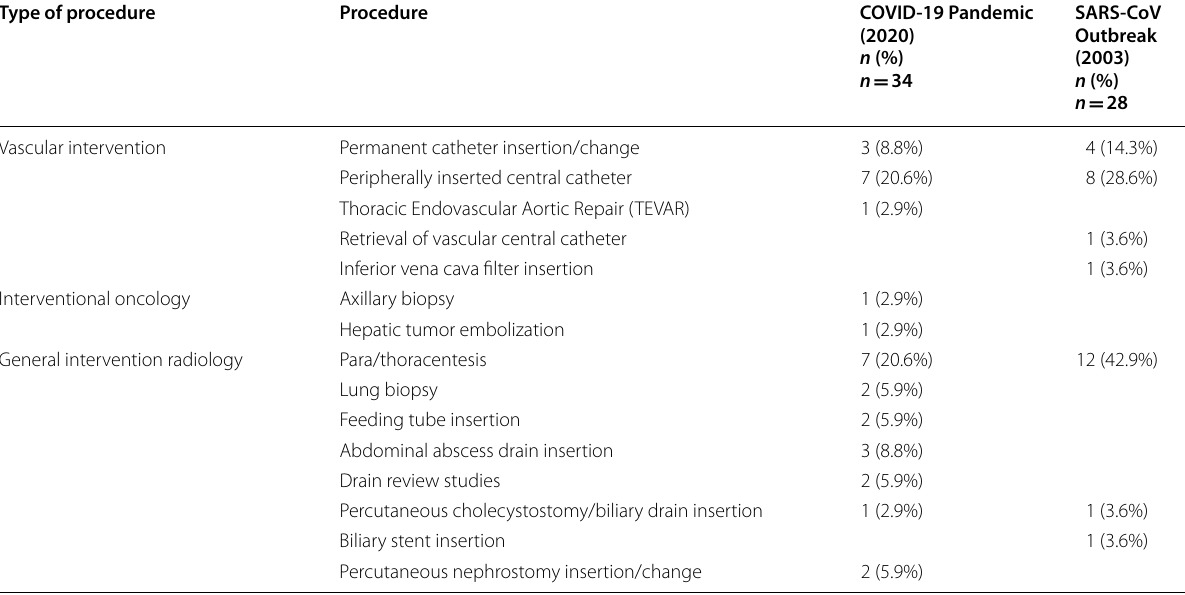
increasing number of General intervention treatments and interventional oncology treatments were performed during the COVID-19 pandemic compared to the SARS-CoV